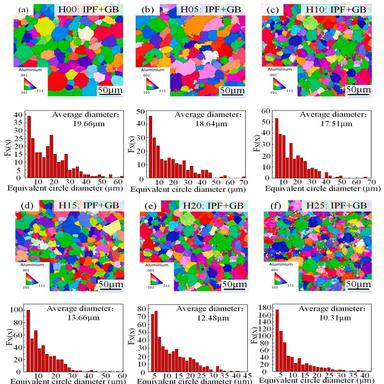
EBSD map showing the grain orientation in TiB2/Al7050 composites and the statistics data of the equivalent circle diameter of grains: (a) H00; (b) H05; (c) H10; (d) H15; (e) H20; (f) H25.